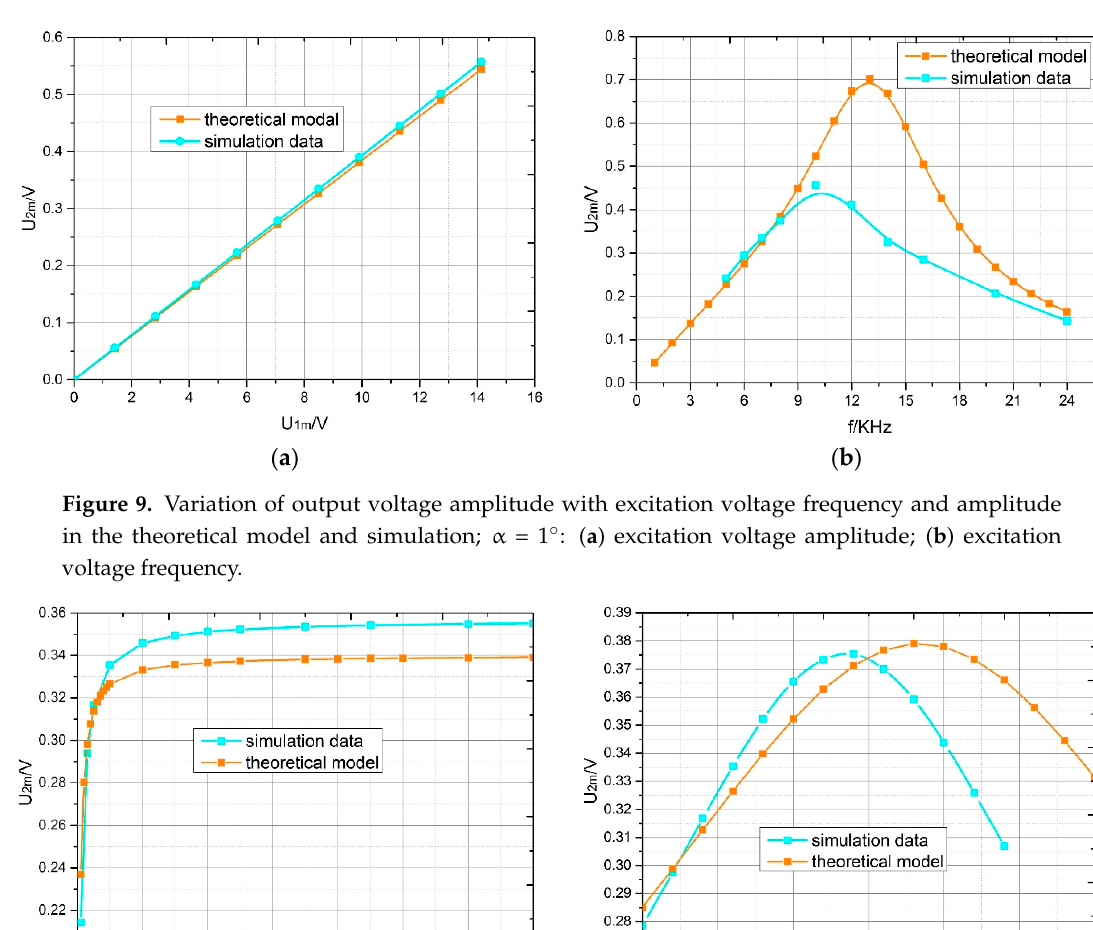
Figure 9. Variation of output voltage amplitude with excitation voltage frequency and amplitude in the theoretical model and simulation; α = 1°: ( a ) excitation voltage amplitude; ( b ) excitation voltage frequency.